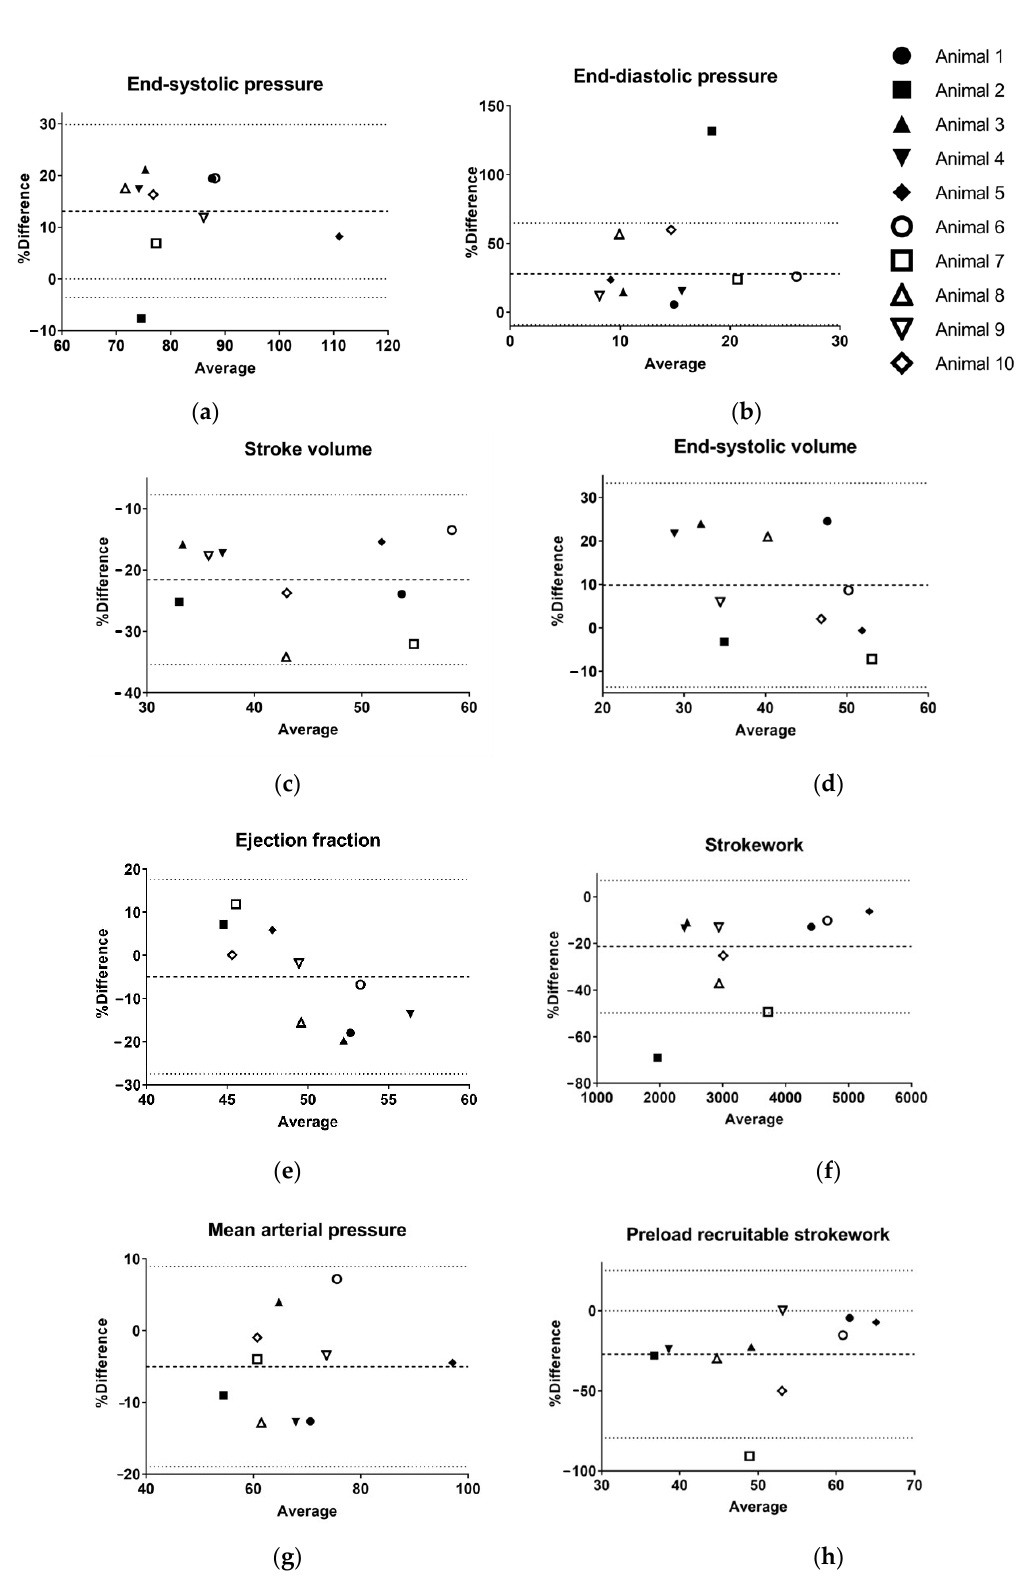
Figure 6. Bland–Altman plots for output parameters of selected haemodynamic parameters: end- systolic pressure ( a ), end-diastolic pressure ( b ), stroke volume ( c ), end-systolic volume ( d ), ejection fraction ( e ), stroke work ( f ), mean arterial pressure ( g ) and preload recruitable stroke work ( h ). The mean difference between the in vivo and simulation data, in percentage, is shown as a detached line. The 95% limits of agreement are indicated by dotted lines.